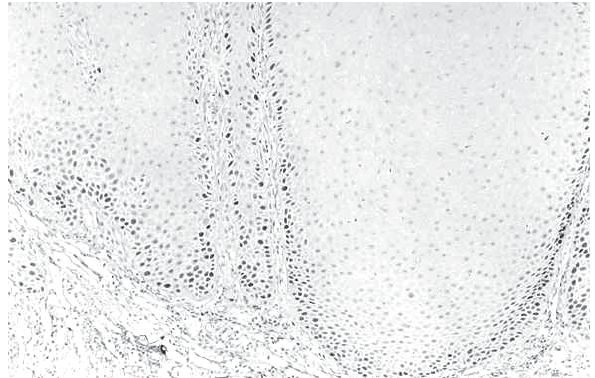
FIGURE 2- Leukoplakia degree III. PCNA-positive cells in basal and parabasal layers (original magnification: TABLE 3- PCNA-positive cells score (Area: 19,500µm.